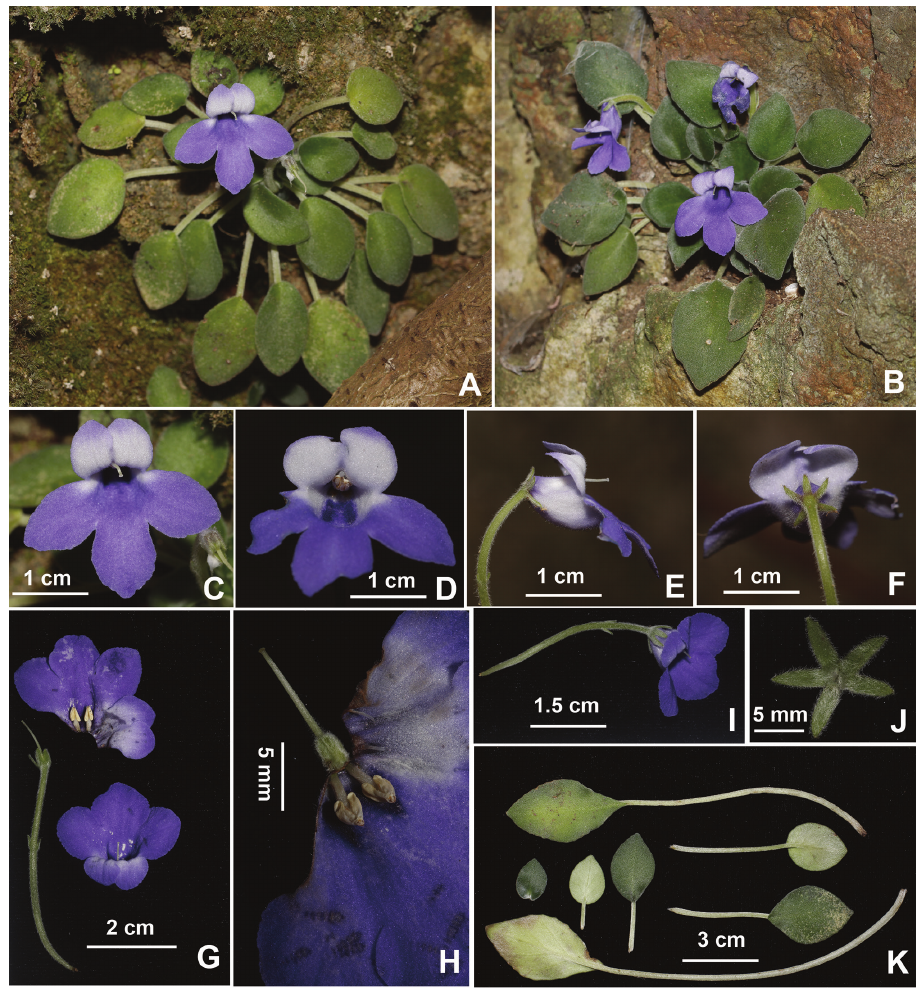
Figure 1. Petrocosmea rhombifolia Y.H.Tan & H.B.Ding, sp. nov. A, B Habit C, D flower in front view E flower in side view F flower in back view G flower H dissected corolla (showing pistil and stamens) I cyme J calyx in abaxial view K leaves. Photographed by H.B.